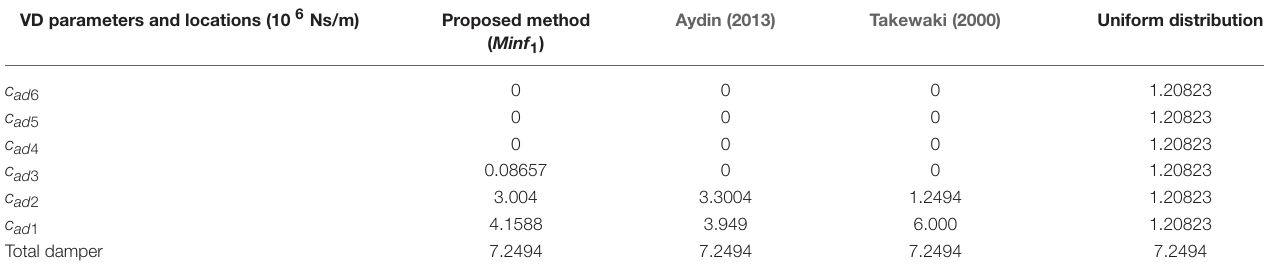
TABLE 1 | Properties of VDs parameters and their locations to the floors. VD parameters and locations (10 6